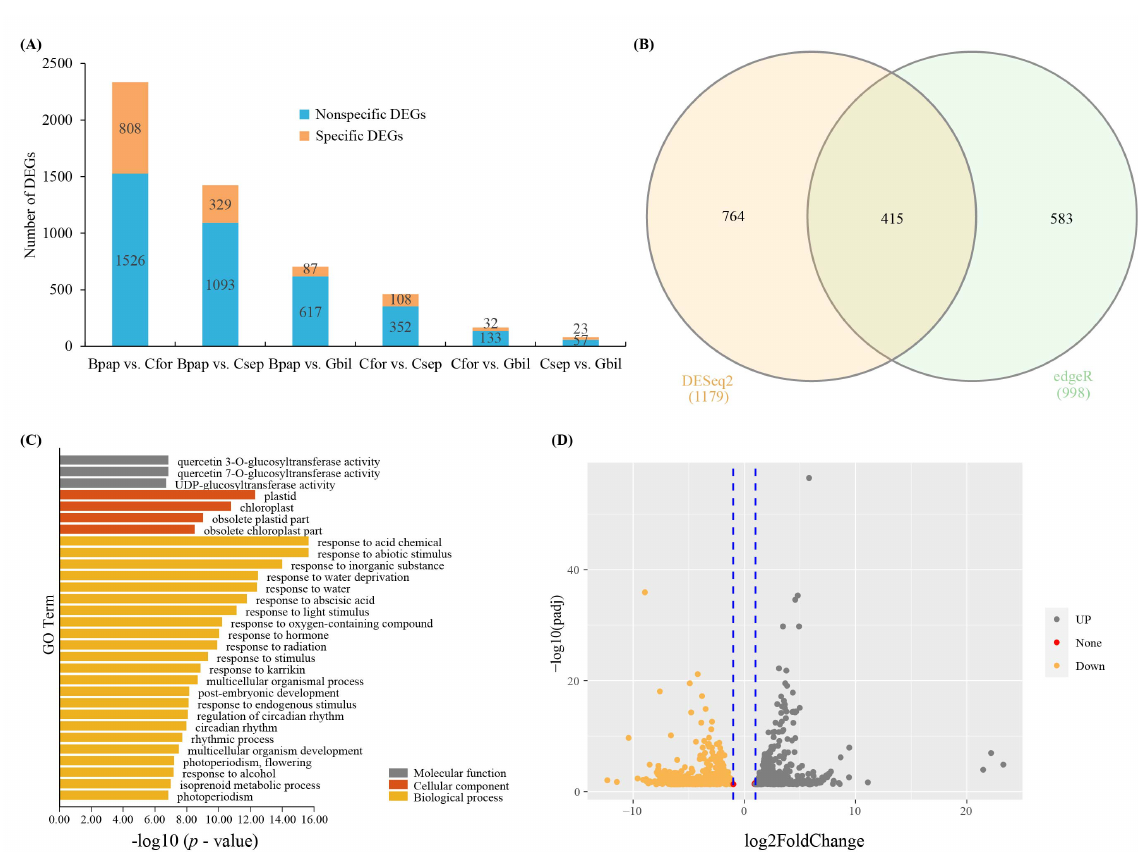
Figure 2. Summary of differentially expressed genes (DEGs). ( A ) The number of DEGs for each pairwise comparison. ( B ) Common unigenes based DESeq2 and edgeR. ( C ) GO enrichment of common unigenes. ( D ) The volcano map DEGs.